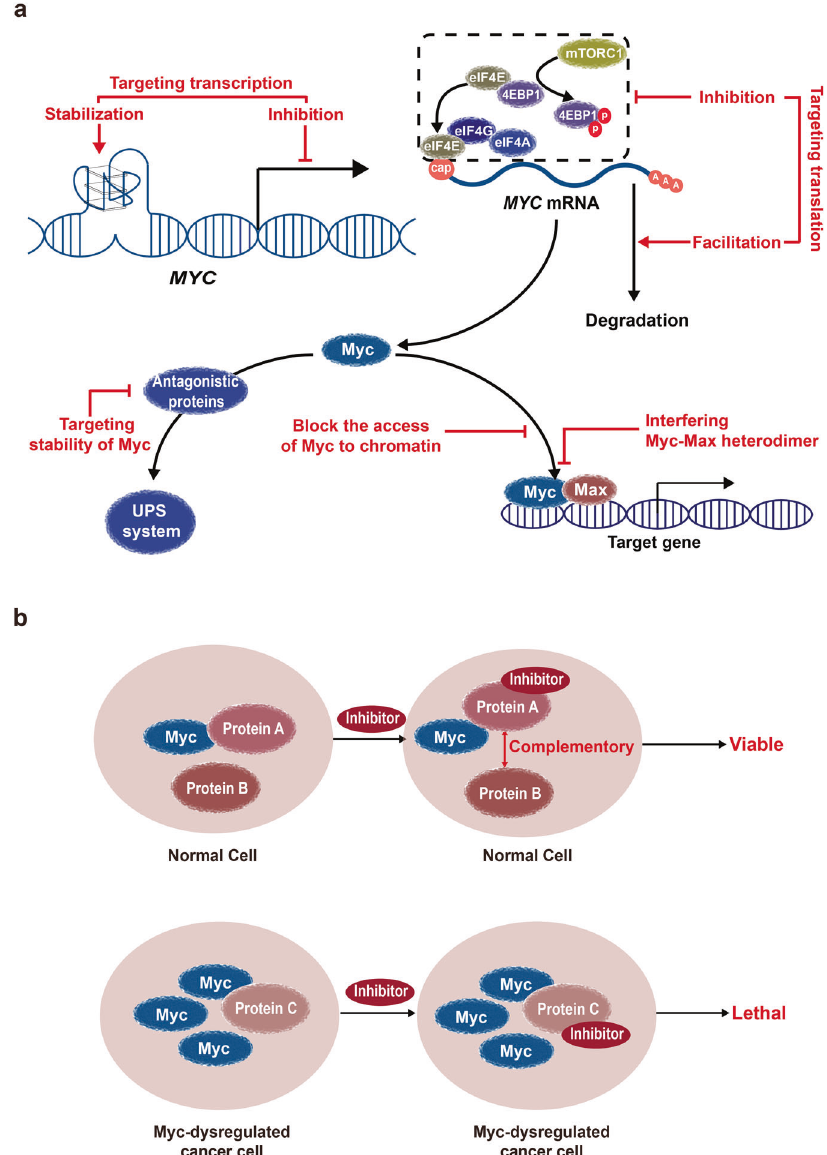
Fig. 3 Alternative approaches to target Myc. a Targeting Myc through the downregulation of Myc protein level and restraining the oncogenic activity of hyperactivated Myc. Targeting the transcription of Myc is a straightforward method to target Myc alternatively either through stabilizing the G-quadruplex structure with small molecules or blockading the signal transduction from MYC to RNA polymerase. The inhibition of the translation process from MYC mRNA to Myc through targeting critical proteins involved in the translation initiation or MYC mRNA stability could also be considered. Other alternative ways to target Myc are hijacking the UPS system to downregulate the Myc protein level, blocking the free access of Myc to its target, and disrupting the interface between Myc and Max. b Targeting Myc through synthetic lethality. Myc-deregulated cancer cells reshuf fl e the inner signal modules and rely on speci fi c signal components to meet the growing demands to thrive as compared to the normal cells. The inhibition of such components leads to synthetic lethality of cancer cells with Myc overexpression. Conversely, normal cells have abundant complementary signaling pathways to buffer such inhibition and yet be viable di fl uoro-substituted quinoxaline, is recently reported to have G-quadruplex structures are frequently present in cancer states selective and potent binding to the G-quadruplex of Myc. QN-1 than in normal states of the cells. 21 For example, higher levels of has a signi fi cant MYC binding preference among genes with G- G-quadruplex structures were observed in antibody staining of quadruplexes, including VEGF , BCL2 , and HRAS . Besides, QN-1 stomach and liver cancer tissues as compared to their normal potently downregulates MYC transcription in triple-negative counterparts. Intriguingly, MYC is a robust driver gene in human breast cancer (TNBC) cells and effectively suppresses tumor cancers, which has a G-quadruplex DNA motif in the proximal G/C- growth in a TNBC mouse model. 22 One of the most cutting- rich promoter region, known as the nuclease hypersensitive element III1 (NHE III1; also known as the CT element). Hence, edge researches related to small-molecule stabilizers of G- fi nding suitable small-weight molecules with high af fi nity and quadruplexes in handling Myc-deregulation is the Phase Ib study selectivity to the G-quadruplex of Myc and predictable actions of APTO-253 in patients with relapsed or refractory acute inside the cell compartment is essential. QN-1, a myelogenous leukemia or high-risk myelodysplasia. 23 This Signal Transduction and Targeted Therapy (2021)